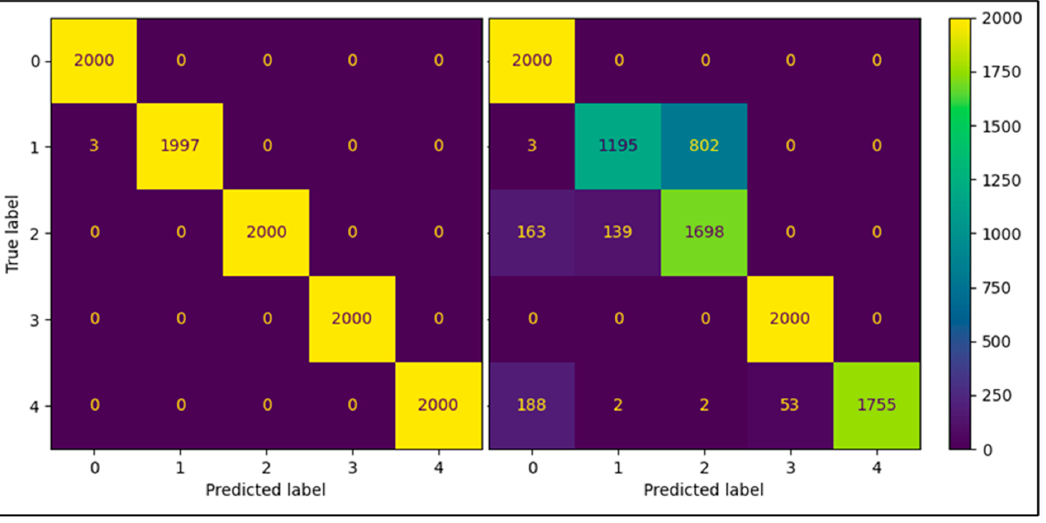
Figure 6. Correlation matrix for leave-out 30 W for RFC ( left ) and SVM ( right ) using the first five principal